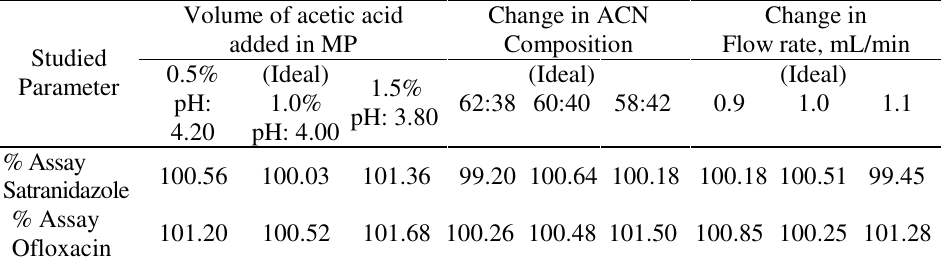
Table 3. Robustness study for satranidazole and